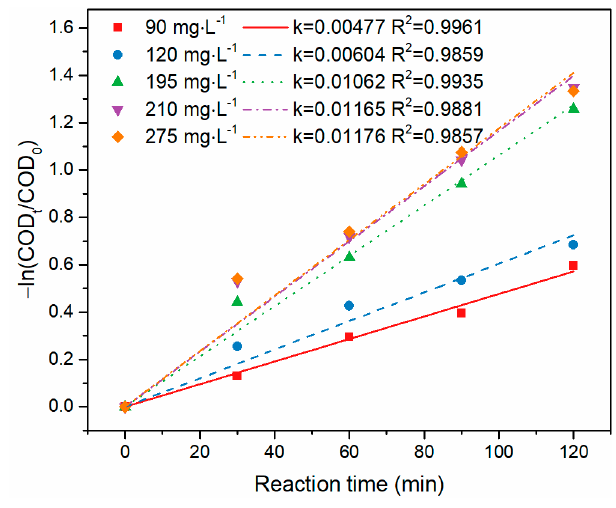
Figure 6. The effect of ozone dosage on the reaction rate constants. Table 3. Kinetic constants of COD removal by the catalytic ozonation or single ozonation system. Catalytic Ozonation Single Ozonation B-A